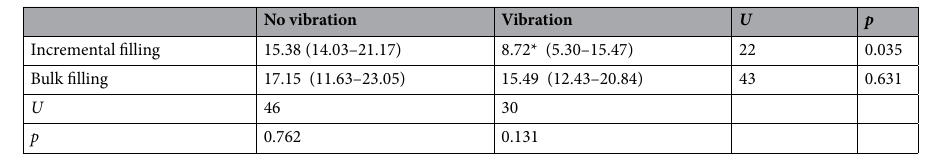
Table 3. Surface adaptation (void area %) at the cavity floor. Interquartile ranges (first quartile, third quartile) are in parentheses. An asterisk indicates significantly higher void volumes within the same filling technique between no vibration and vibration (row) (Mann–Whitney U test, p < 0.05). U, U-value; p , p-value.